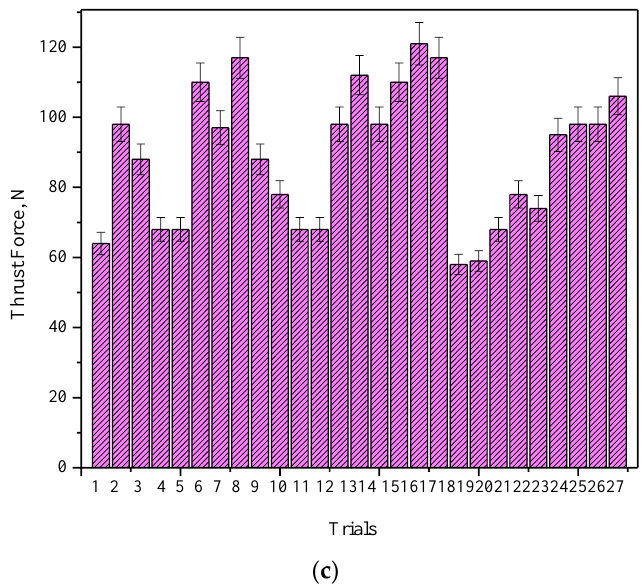
Figure 8. Measured thrust force for input factors using dynamometer on composites. ( a ) Composition 70:30. ( b ) Composition 75:25. ( c ) Composition 80:20.